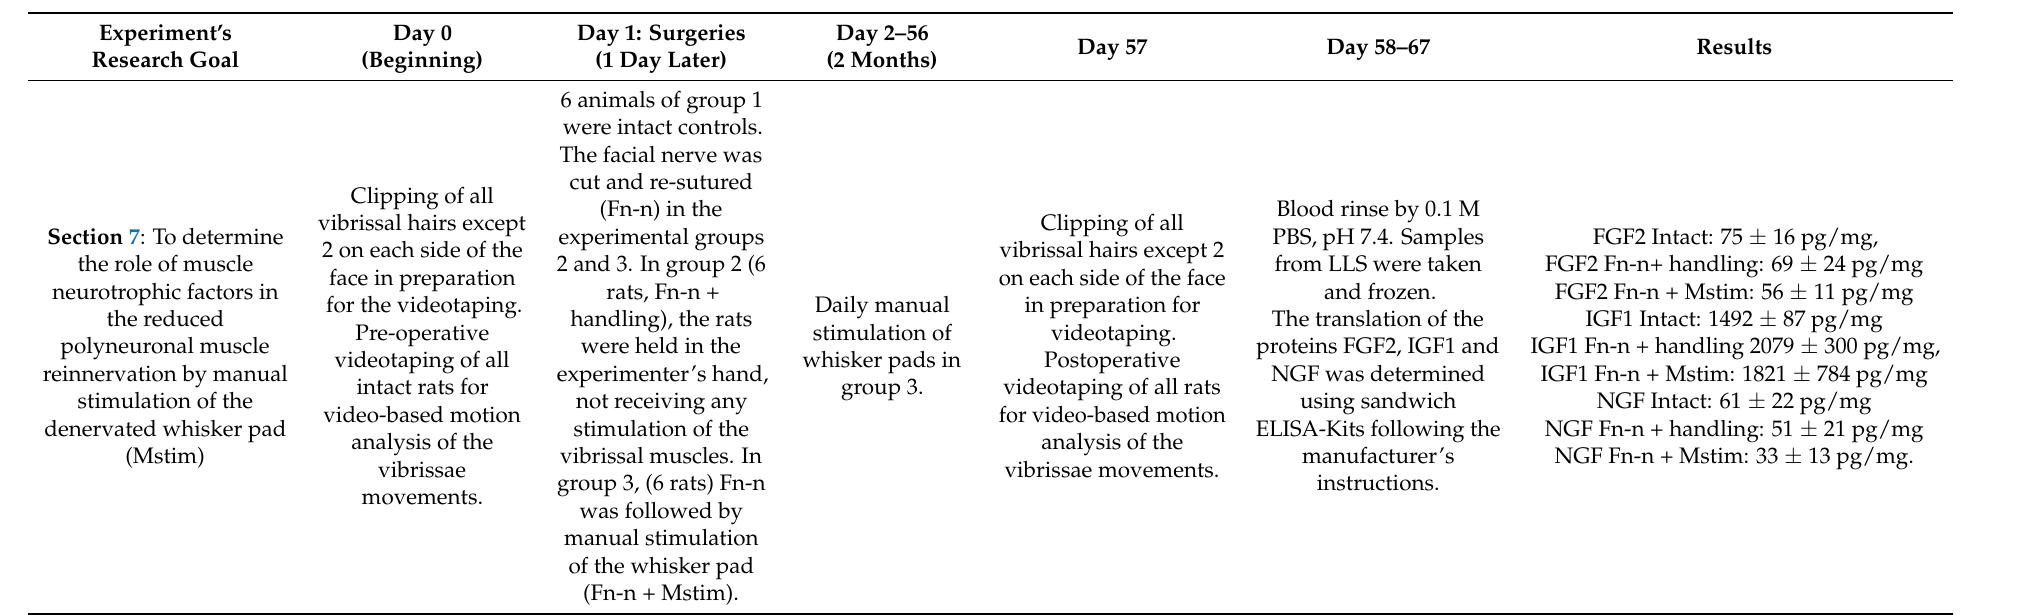
Table 7. Experimental design flow chart depicting animal grouping and sequence of the main procedures in the section describing the role of muscle neurotrophic factors in the reduced polyneuronal muscle reinnervation by manual stimulation of the denervated whisker pad. Fn-n, transection and suture of the facial nerve. Mstim, manual